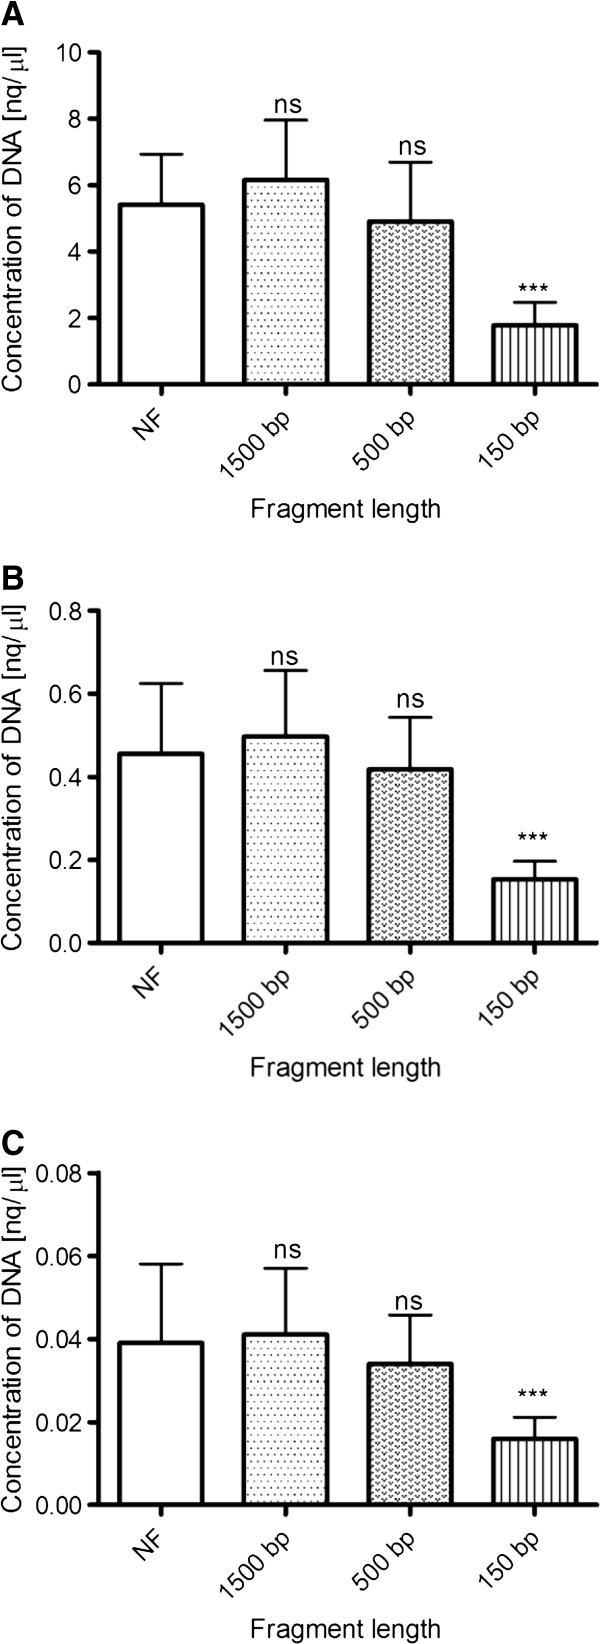
The DNA quantification by qPCR with an Alu-based assay. (A) The quantity of the most fragmented 10-fold diluted samples with a length of approx. 150 bp was significantly affected by the degree of the fragmentation. The same situation is shown in the case of 100-fold diluted (B) and 1000-fold diluted (C) samples as well. ns, statistically non-significant; ***, p< 0.0001.